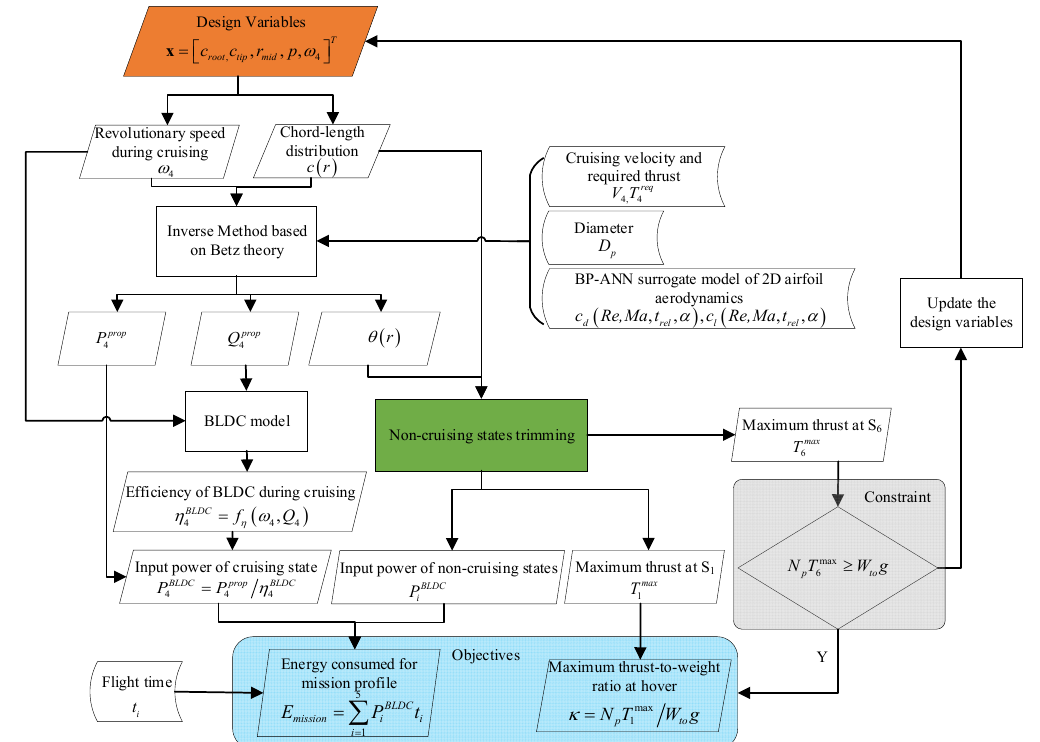
Figure 13. The flowchart of optimization framework for the VTOL propeller.